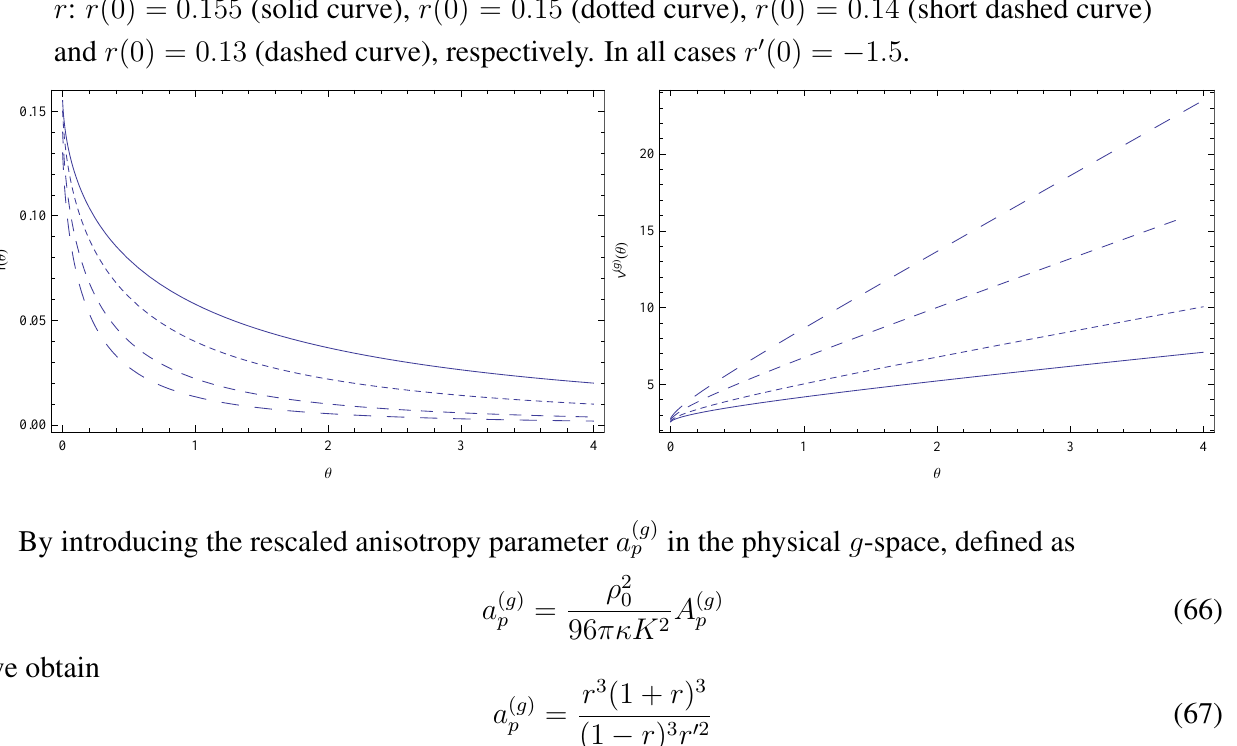
Figure 1. Variation of the dimensionless energy density r of the stiff fluid filled Bianchi type I space-time in EiBI gravity ( left figure) and of the comoving volume v ( g ) in the physical space g ( right figure), for different initial values of the dimensionless energy density r : r (0) = 0 . 155 (solid curve), r (0) = 0 . 15 (dotted curve), r (0) = 0 . 14 (short dashed curve) and r (0) = 0 . 13 (dashed curve), respectively. In all cases r (cid:48) (0) = − 1 . 5 .